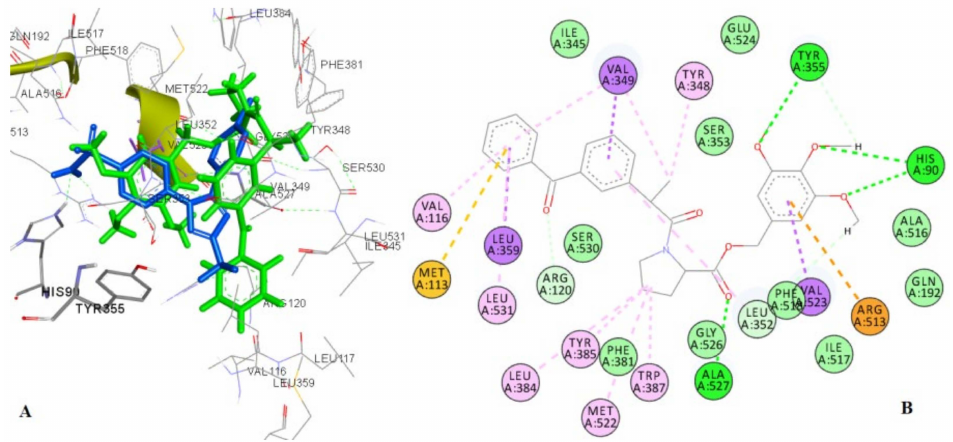
Figure 4. ( A ). Docked compound 19 (green) superimposed on the co-crystallized SC-558 (blue) in the binding pocket of COX-2. ( B ) 2D diagram of compound 19 in the binding pocket of COX-2. Hydrogen bonds are shown as green dotted